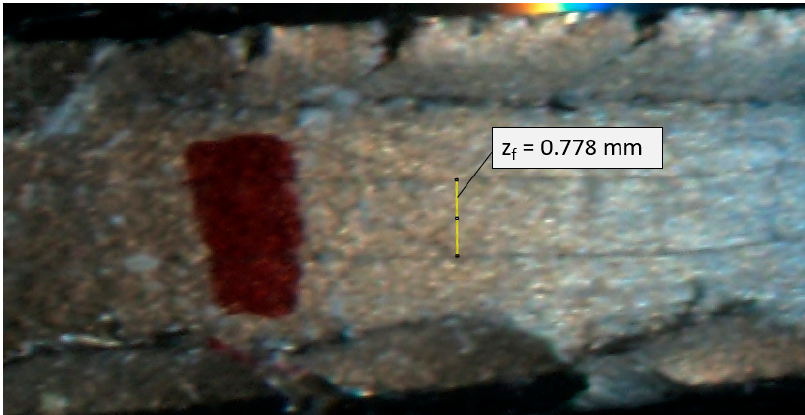
z in a specimen of Series f